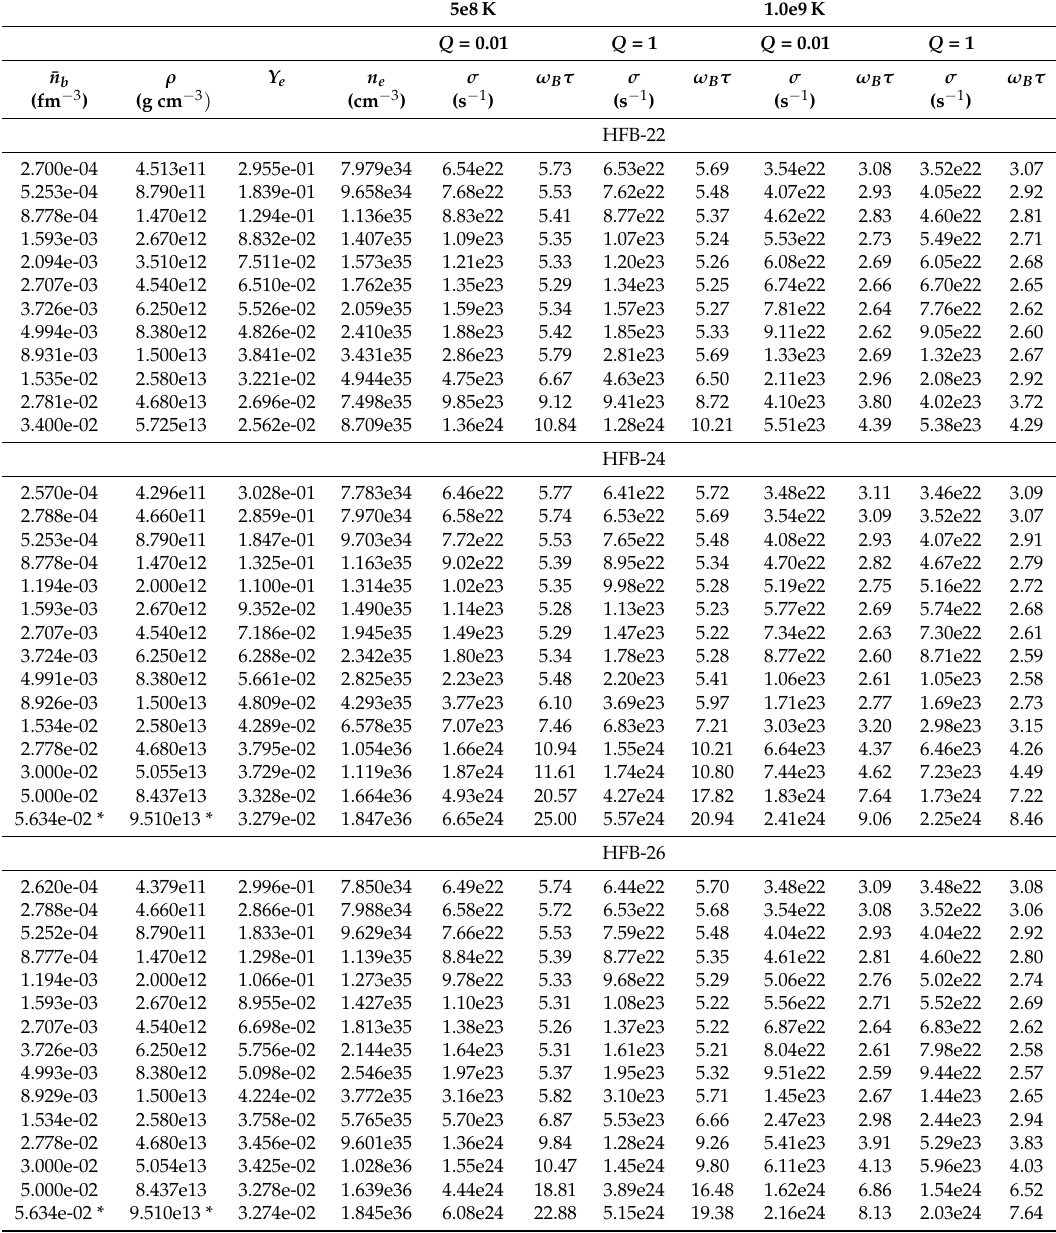
Table A1. Table 1 Partial values of electrical conductivity and magnetization parameter for two different temperatures T and two different impurity parameters Q in the inner crust of NSs for the nuclear mass models HFB-22, HFB-24 and HFB-26. The unit of magnetization parameter ω B τ is the normalized magnetic field B 14 when the dipolar magnetic field strength B = 1.0 × 10 14 G. Here the crust is assumed to be